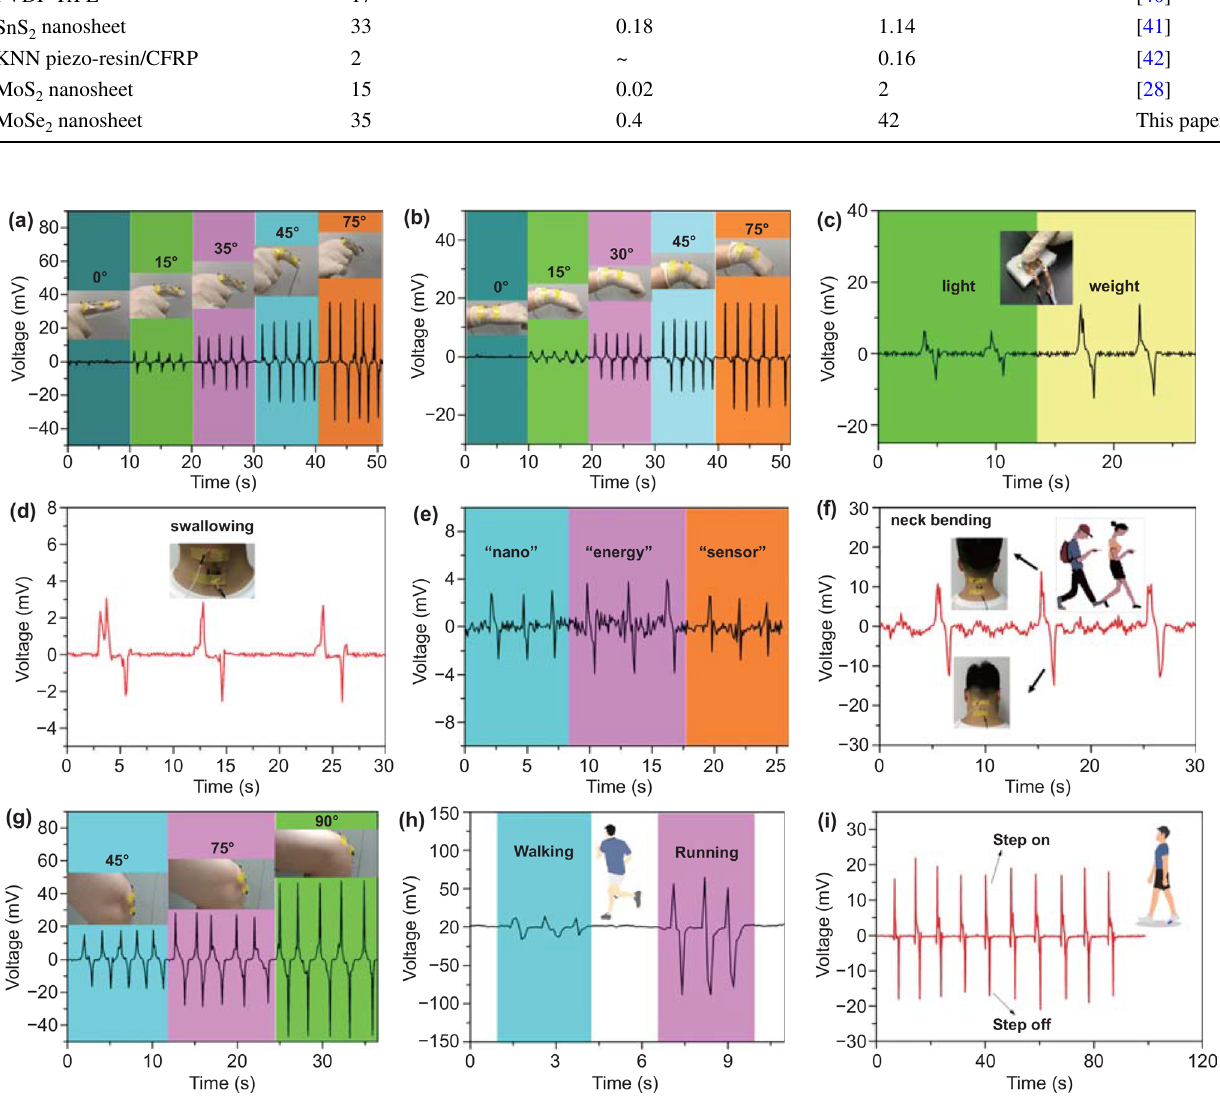
Fig. 3 Energy harvesting and application of MoSe 2 device on various parts of the human body a Index finger joint. B Wrist. c Finger press. d Throat. e Output voltage change of flexible PENG in terms of various sound stimuli, such as “nano,” “energy,” and “sensor.” f Neck bending. g Knee bending. h, i Human motion